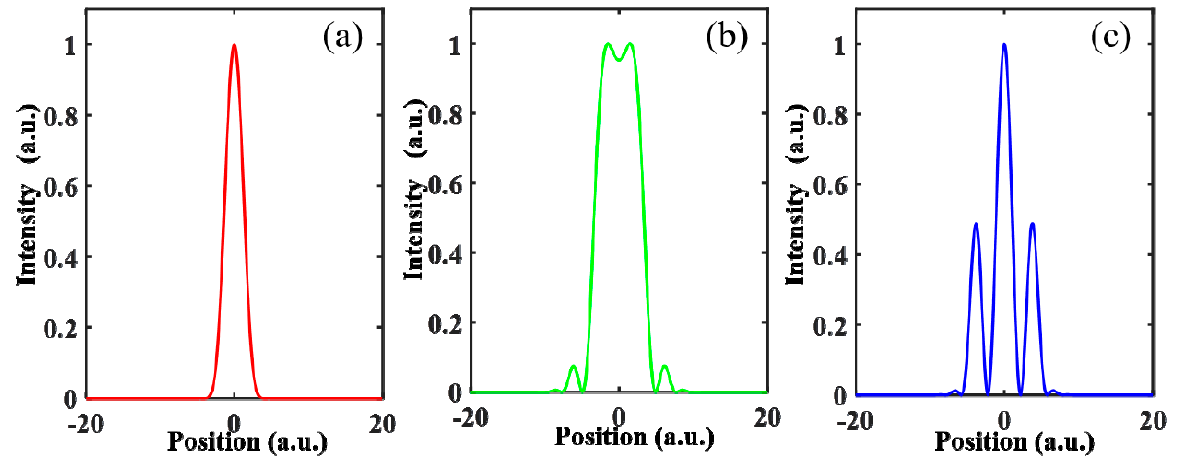
Figure 1. When x 0 = 1, the waveform of Cos − Gaussian pulses with different initial phases φ 0 : ( a ) φ 0 = π /6, ( b ) φ 0 = 3 π /8 and ( c ) φ 0 = 2 π /3.